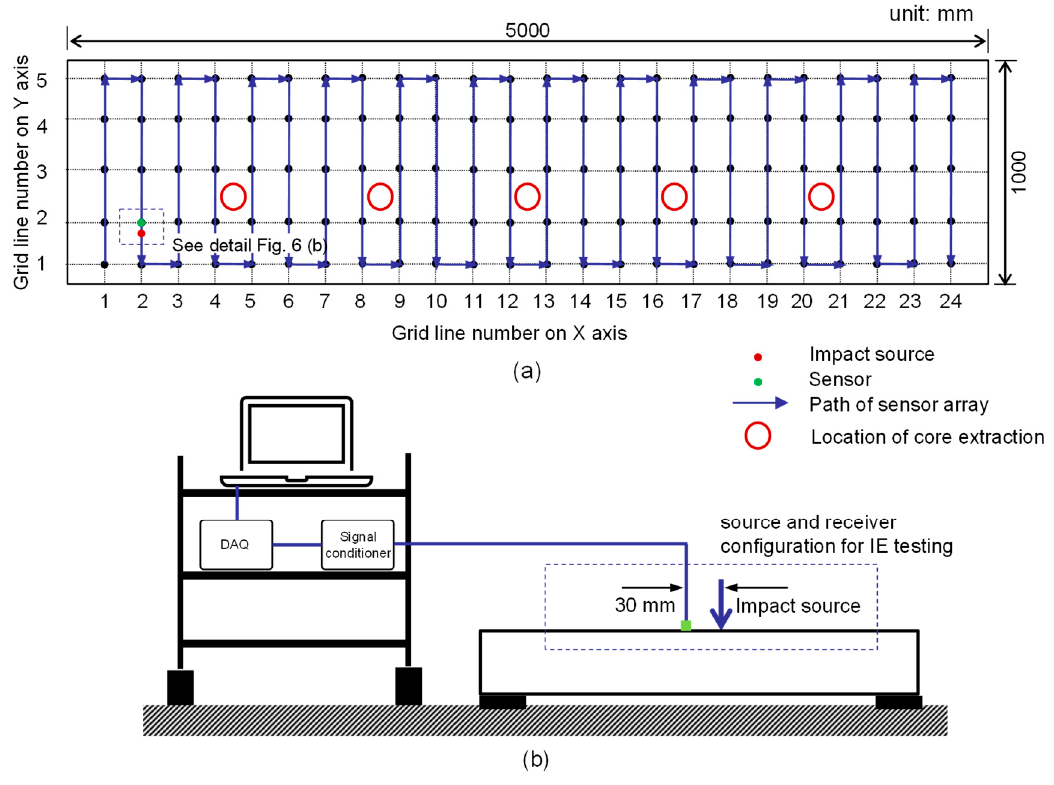
Figure 6. Test setup and procedure of IE testing on the concrete slab specimen: ( a ) test grid and path of sensor array during IE testing and ( b ) test setup of IE testing.